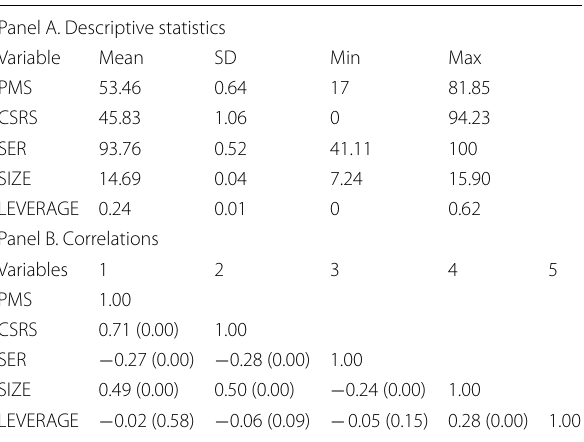
Table 2 Descriptive statistics and correlation coefficients of key